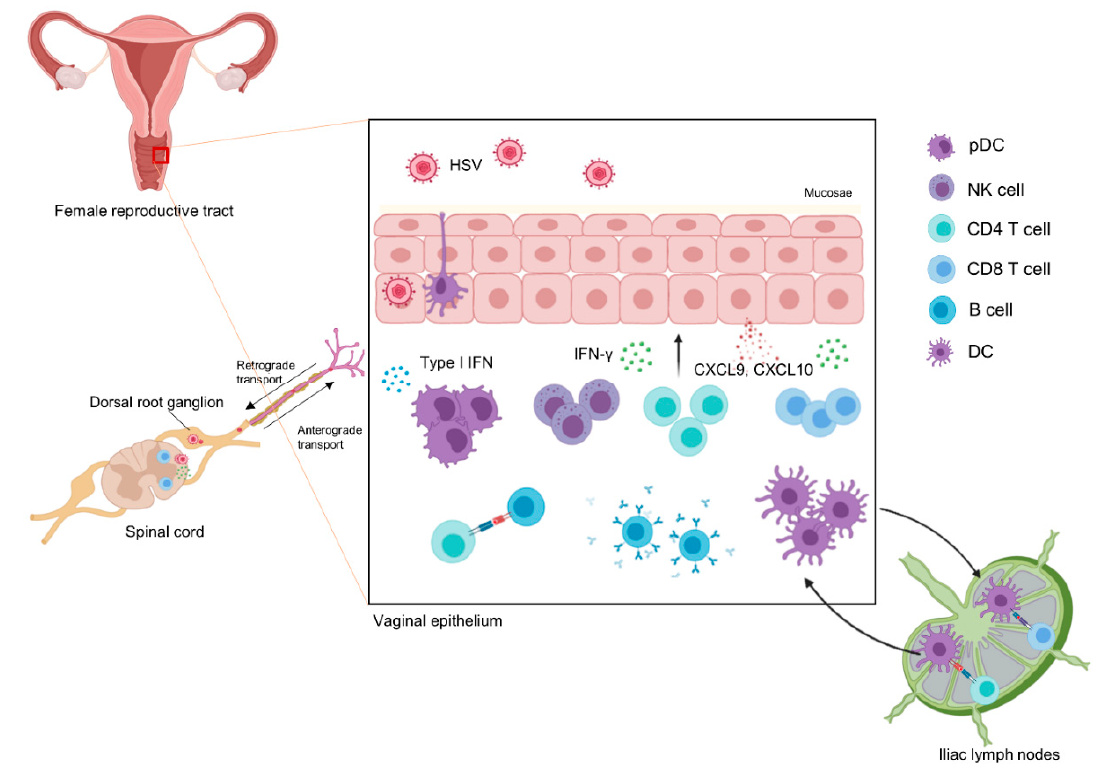
Figure 2. Anti-HSV immune response When HSV enters the female human body, epithelial cells recognize HSV in a PRR-dependent or PRR-independent manner. Then, pDC, NK cells, and DCs are recruited to vaginal tissue. Type I IFN, which is released from pDCs, suppresses viral replication. DCs process viral antigen, migrate to draining lymph nodes, and prime T cells. CD4 T cells appear first and induce the release of chemoattractants CXCL9 and CXCL10 via release of IFN- γ for CD8 T cell recruitment. CD4 T cells also assist B cells to generate antibody against HSV. CD8 T cells kill infected cells and control HSV reactivation. CD4 T cells orchestrate the primary response and CD8 T cells respond quickly to viral replication and reduce genital recurrence. Images are created with BioRender.com.